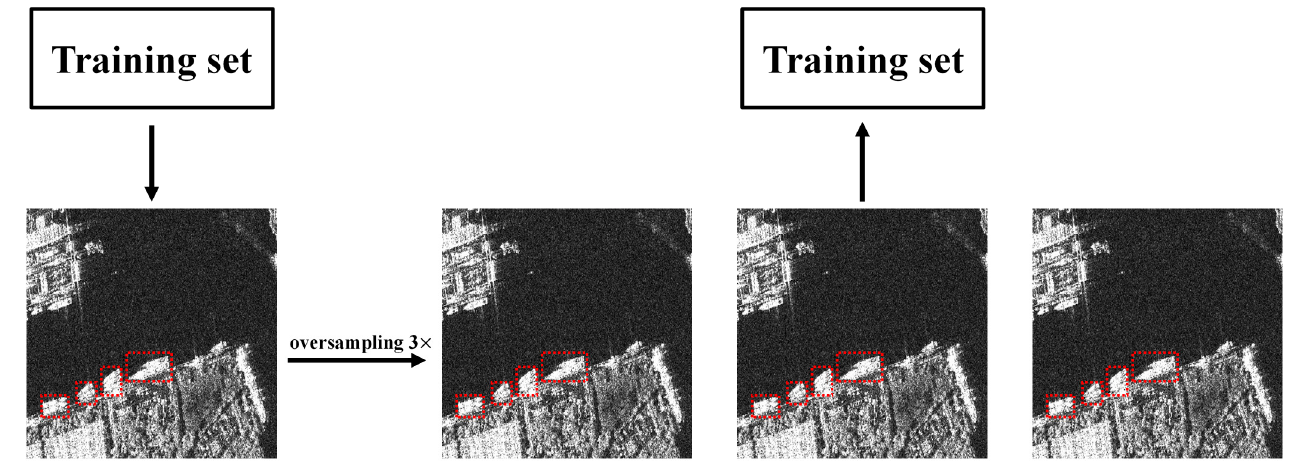
Figure 2. Variation of loss during training on the SSDD dataset.